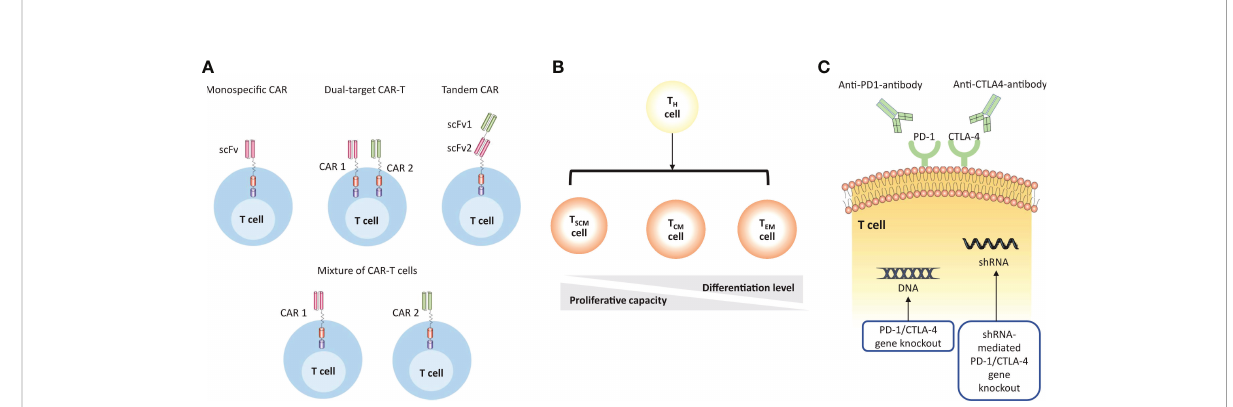
FIGURE 4 Strategies to improve the ef fi cacy of MM CAR-T cell therapy. (A) CAR-T cell products are designed to target multiple TAAs to overcome antigen escape. The monospeci fi c CAR has a single scFv; the dual-target CAR construct includes two separate monospeci fi c CARs on the surface of T cells; the tandem CAR has two antigen-binding domains that are linked tandemly on one CAR protein; the mixture of CAR-T cells describes the simultaneous transduction of different types of CAR-T cells in vivo . (B) The persistence of CAR-T cells can be enhanced by using less- differentiated T cell subsets. (C) CAR-T cells can be engineered to overcome the immunosuppressive microenvironment by using immune checkpoint inhibitors or direct gene